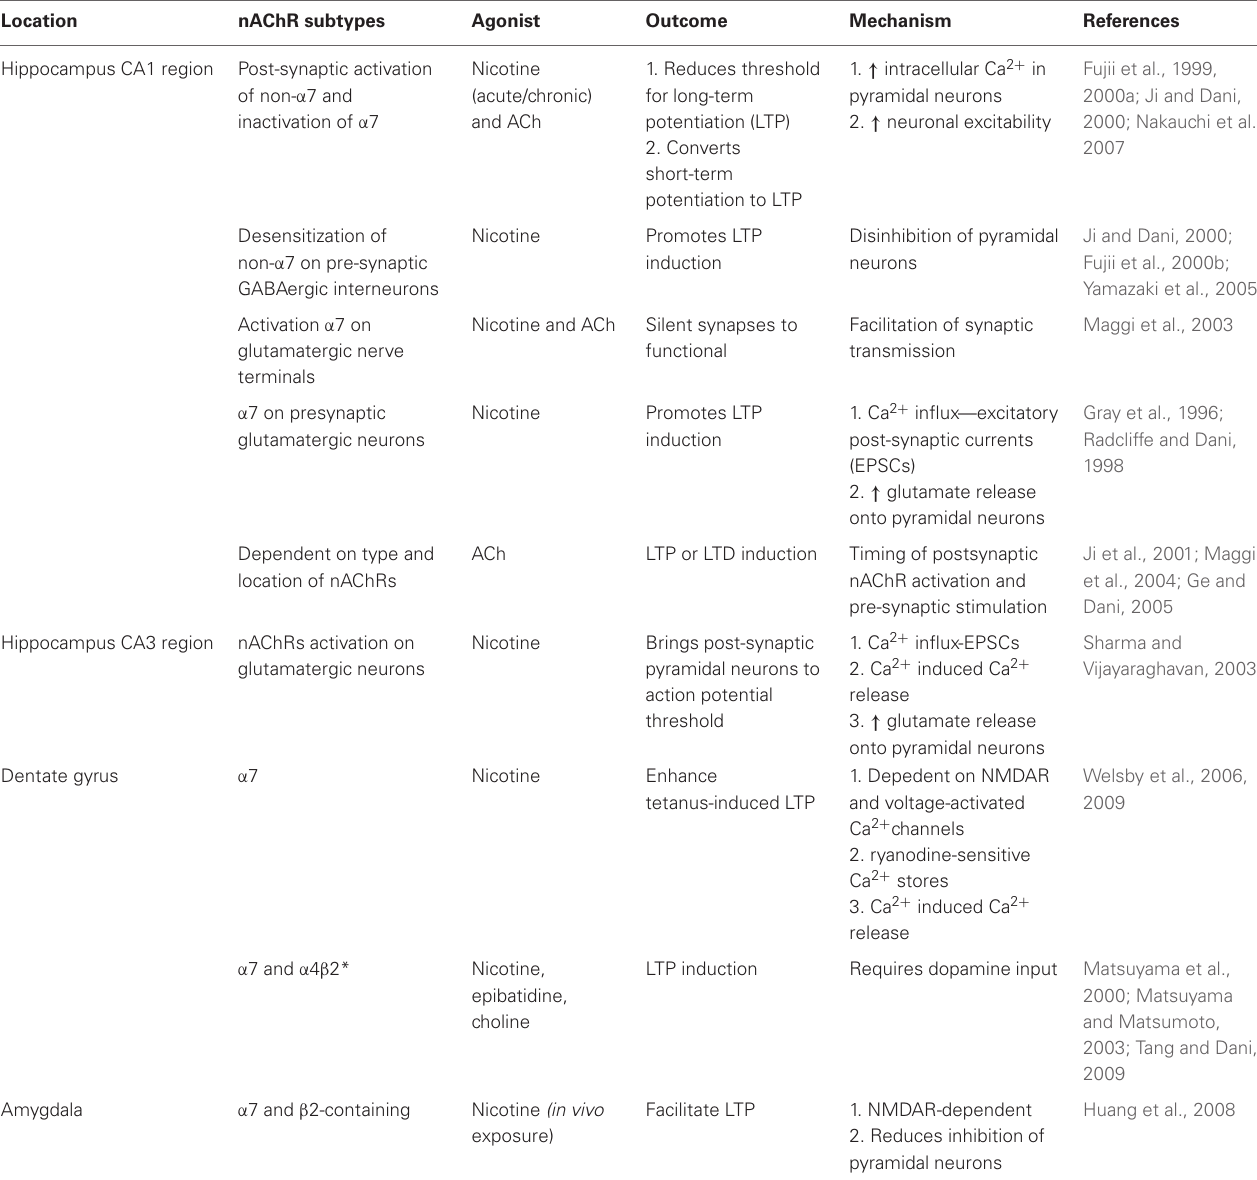
Table 2 | nAChRs modulate synaptic plasticity in the hippocampus and amygdala.